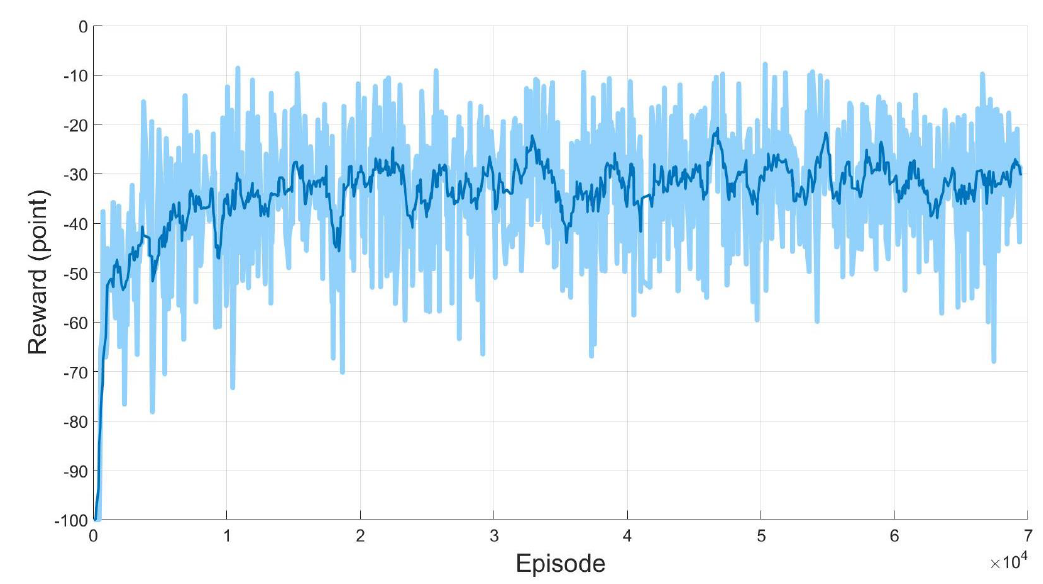
Figure 8. Reward of the proposed SAC-based path planning for two open manipulators with moving obstacles.